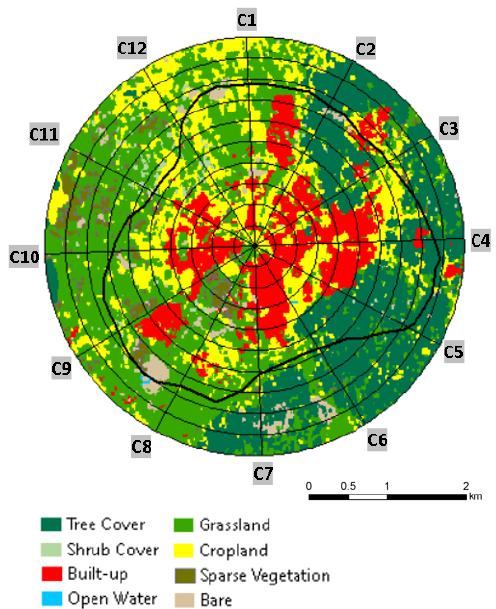
Figure 9. Land cover classification for the urban area of Ifrane (buffers shown every 270 m).